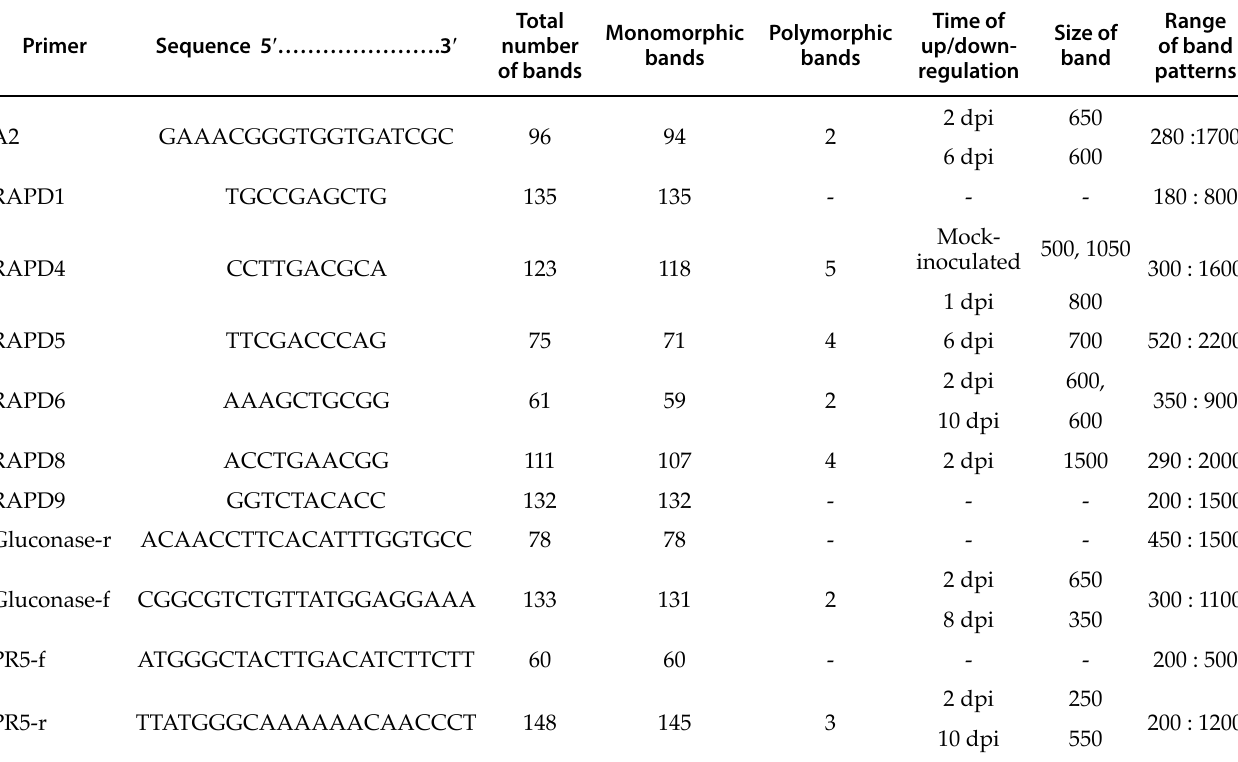
Table 1. Primers used in DD-PCR, and the total numbers of up or down-regulated bands.